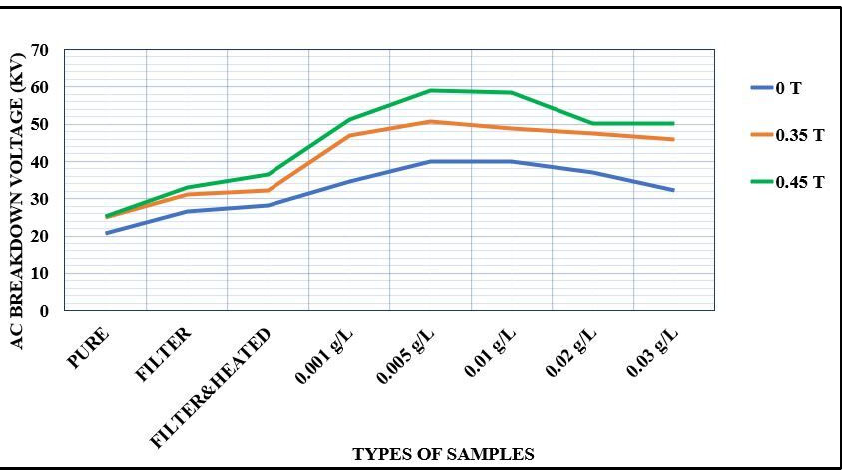
Figure 4. Average breakdown voltages of samples with and without CNT concentrations and different magnetic fields applied. Table 3. Average breakdown voltage of different types of samples and magnetic field strengths. Types of Samples